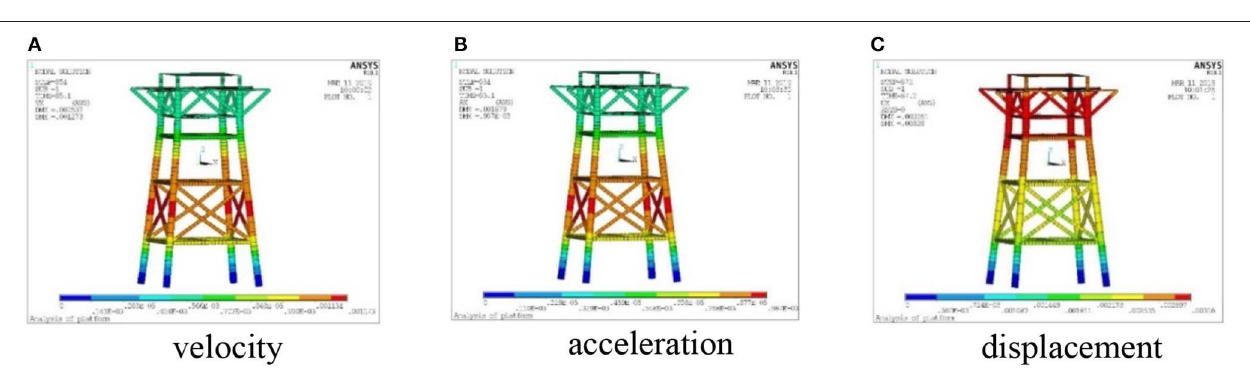
FIGURE 8 | Dynamic response contours under working condition with regular waves. (A) Velocity; (B) acceleration; (C) displacement.